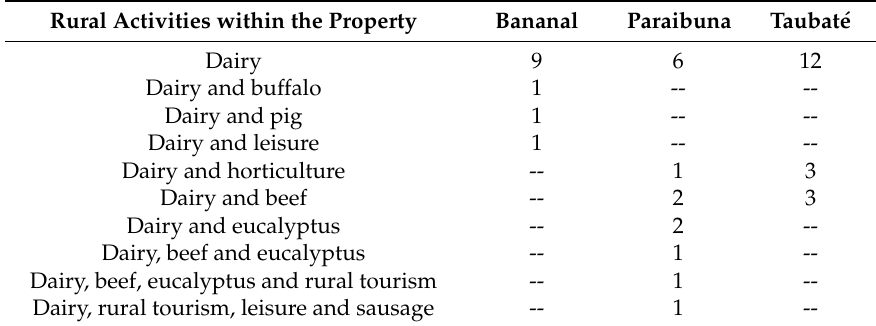
Table 3. Description of the rural activities within the rural